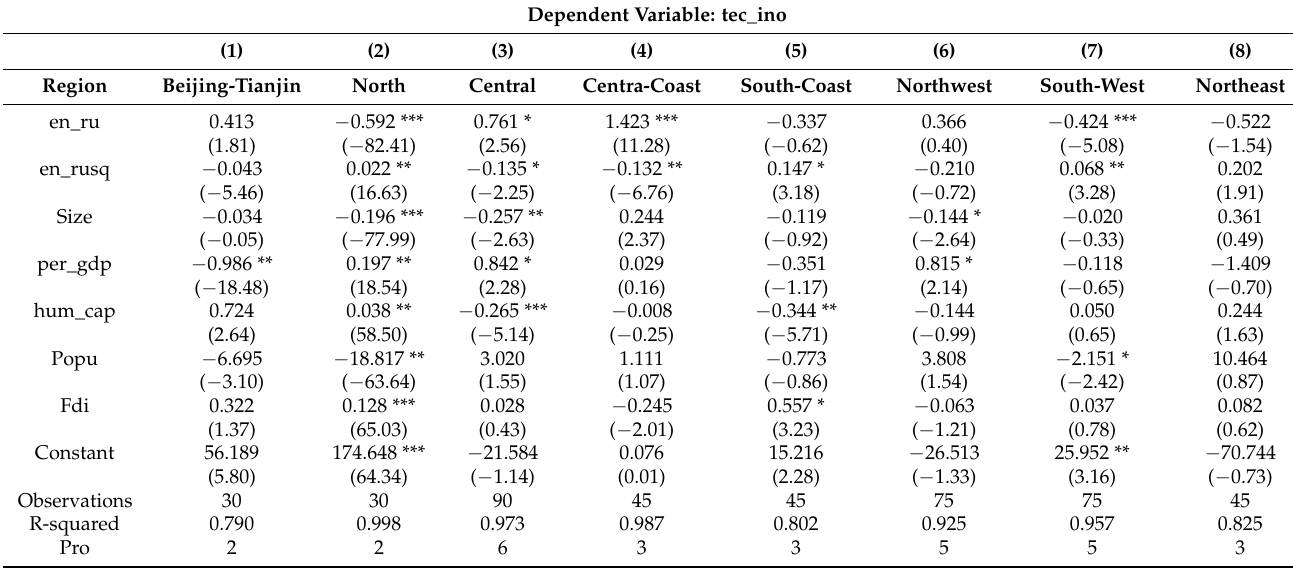
Table 6. The regional grouping